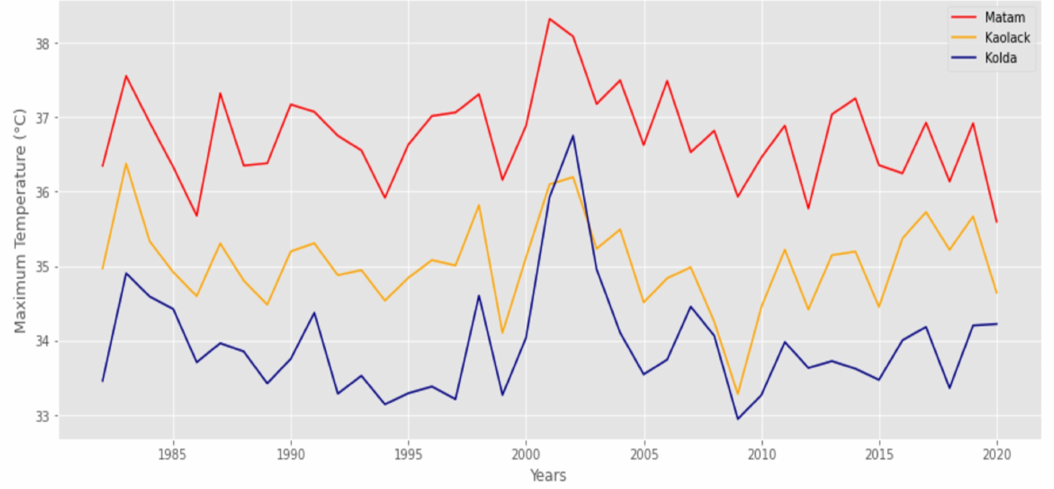
Figure 4. Annual average Maximum Temperature for Matam, Kaolack and Kolda (1982–2020).